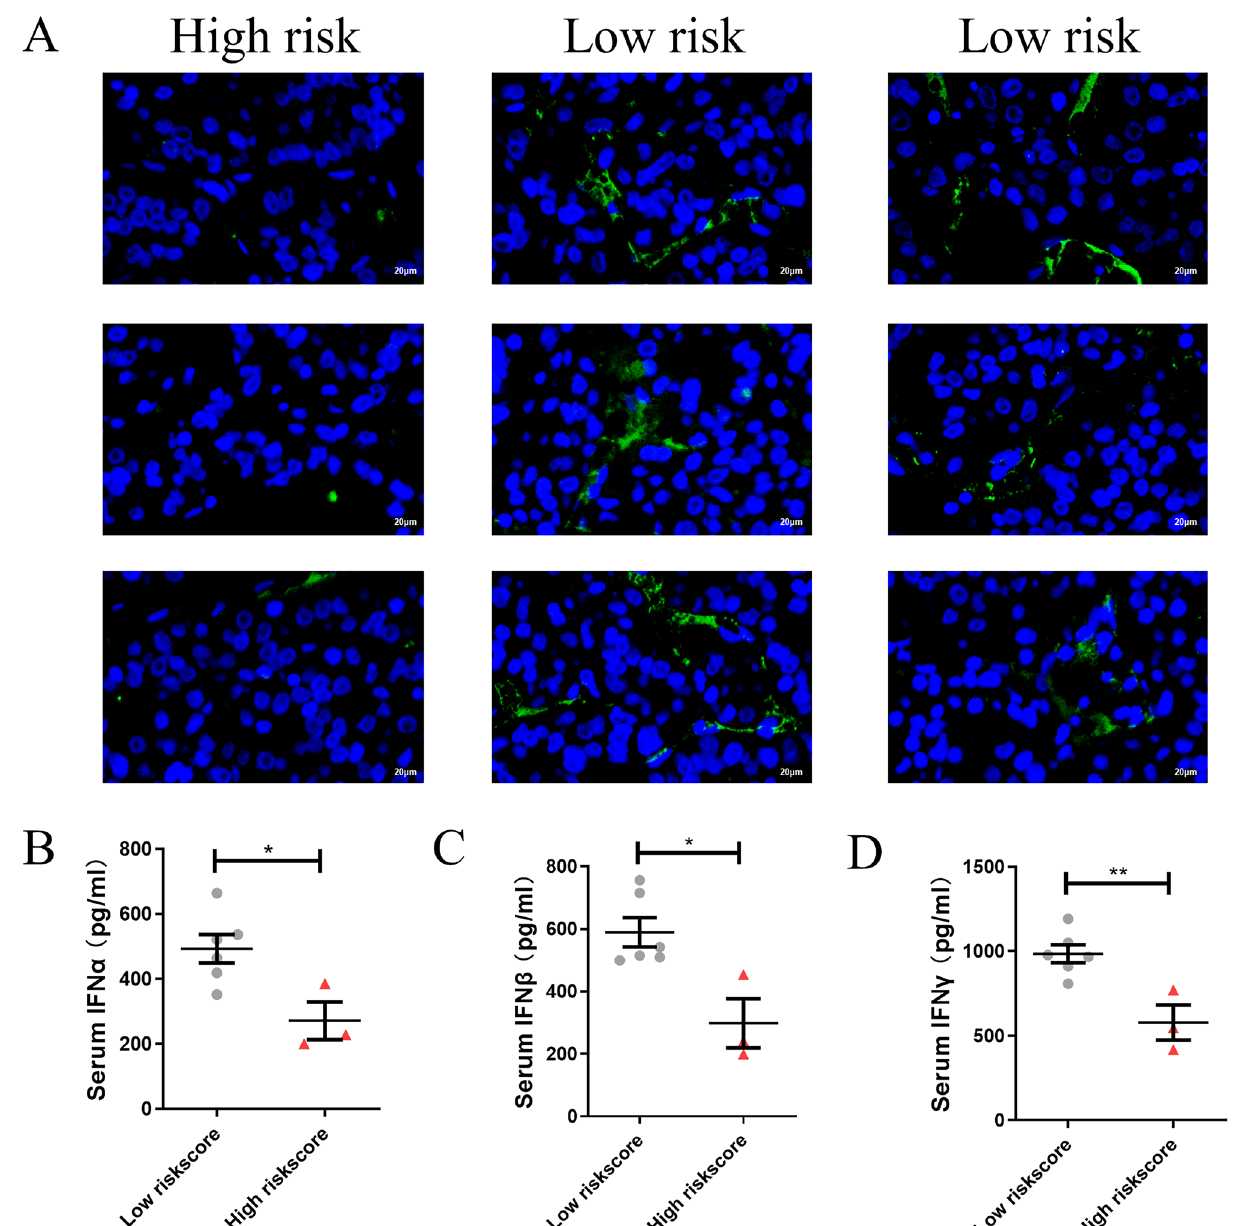
Figure 8. High risk score is associated with immunosuppression in HCC patients. ( A ) Representative images from multiplex immunofluorescent tissue staining for CD56 (green) and DAPI (blue) on high-riskscore and low-riskscore HCC tissues (Scale bar, 20 μm). ( B – D ) Serum IFNα, IFNβ and IFNγ concentration in high- riskscore and low-riskscore HCC